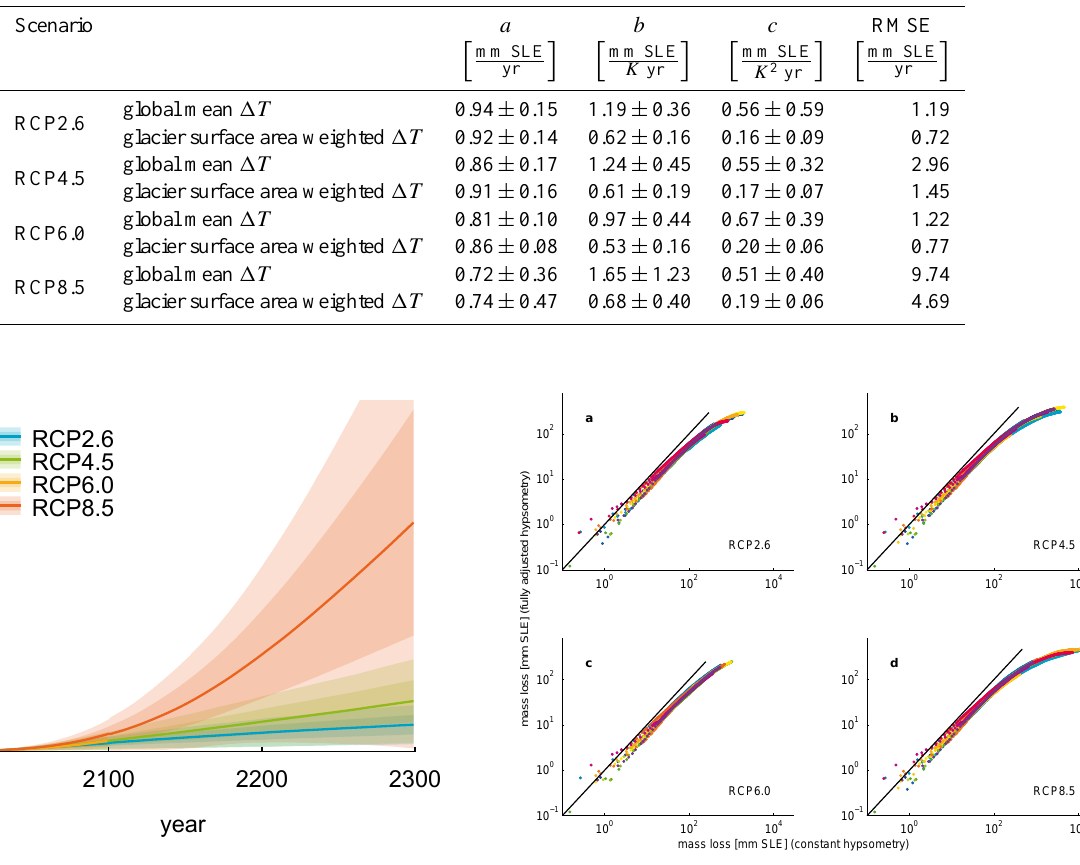
Table 3. Model mean parameters of a function of the form a + b · 1T + c · 1T 2 · 1T | when glacier hypsometry is held constant, and ice volume treated as infinite (Fig. 6). Standard deviation between CMIP5 models given as